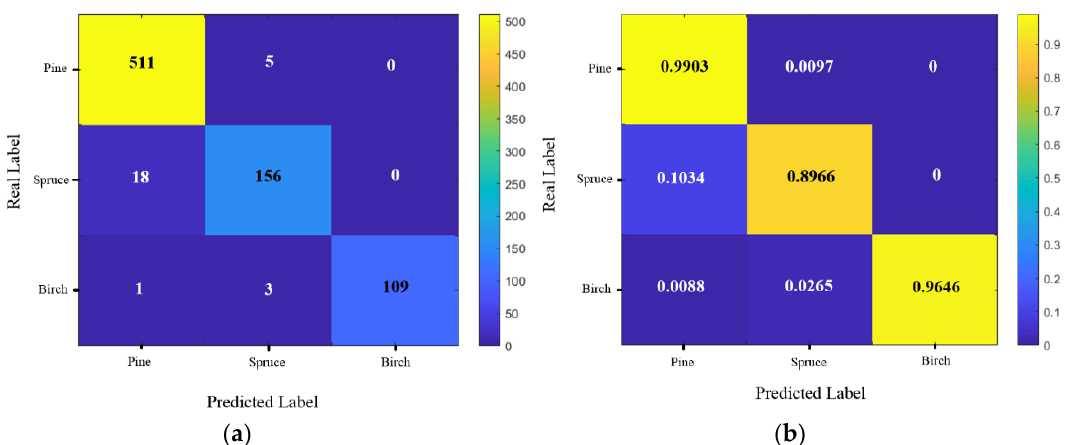
Figure 11. Confusion matrices of the 3D-CNN with CHM and spectral channels ; ( a ) case numbers, ( b ) normalized percentages.